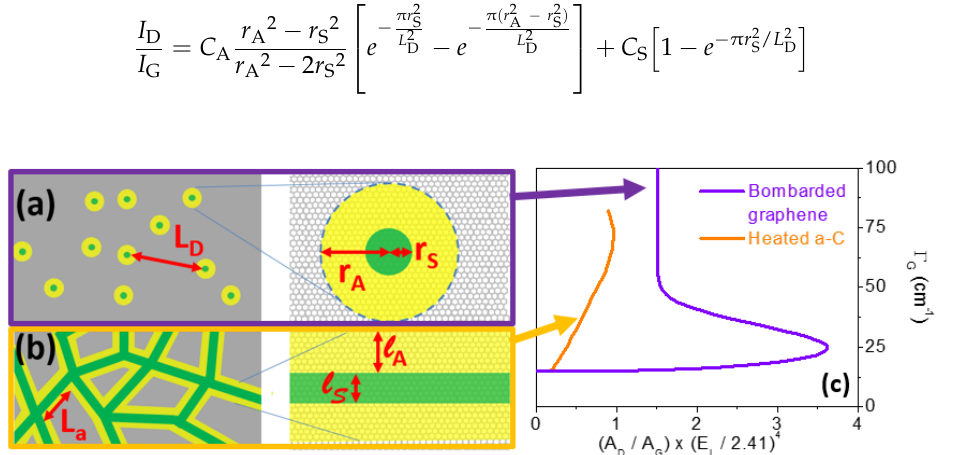
Figure 17. 0D and 1D local activation models. ( a , b ) Definition of the structurally damaged regions and activated regions, with L D , the distance between defects, and L a , the size of crystallites surrounded by edges, for respectively the 0D and 1D defects; ( c ) Г G as a function of A D / A G